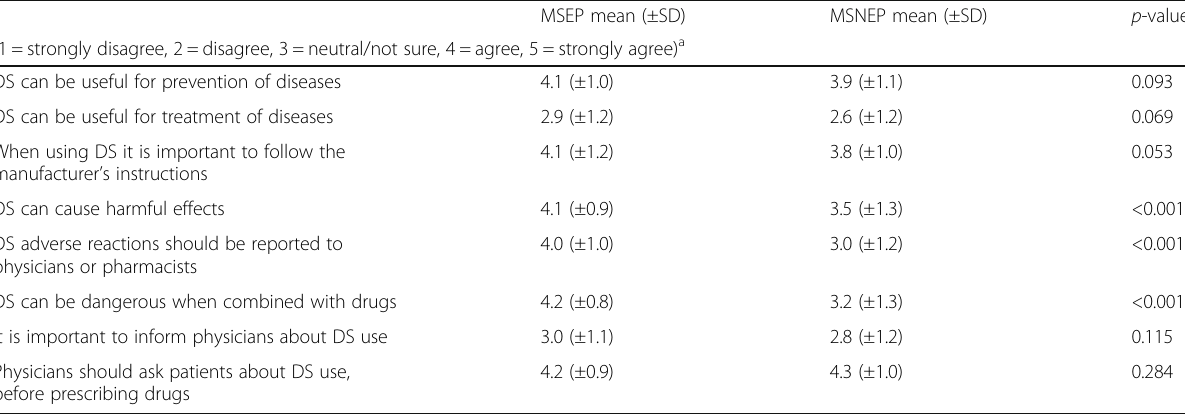
Table 4 Respondents attitudes towards DS